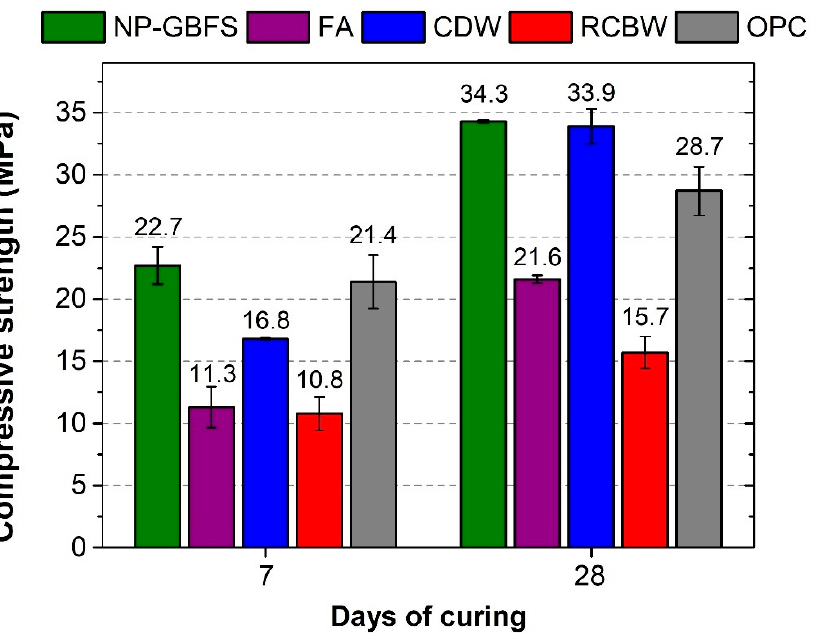
Figure 2. Compressive strength of the mixtures (7 and 28 days) (curing conditions: 25 ◦ C, 80% relative humidity (RH)).